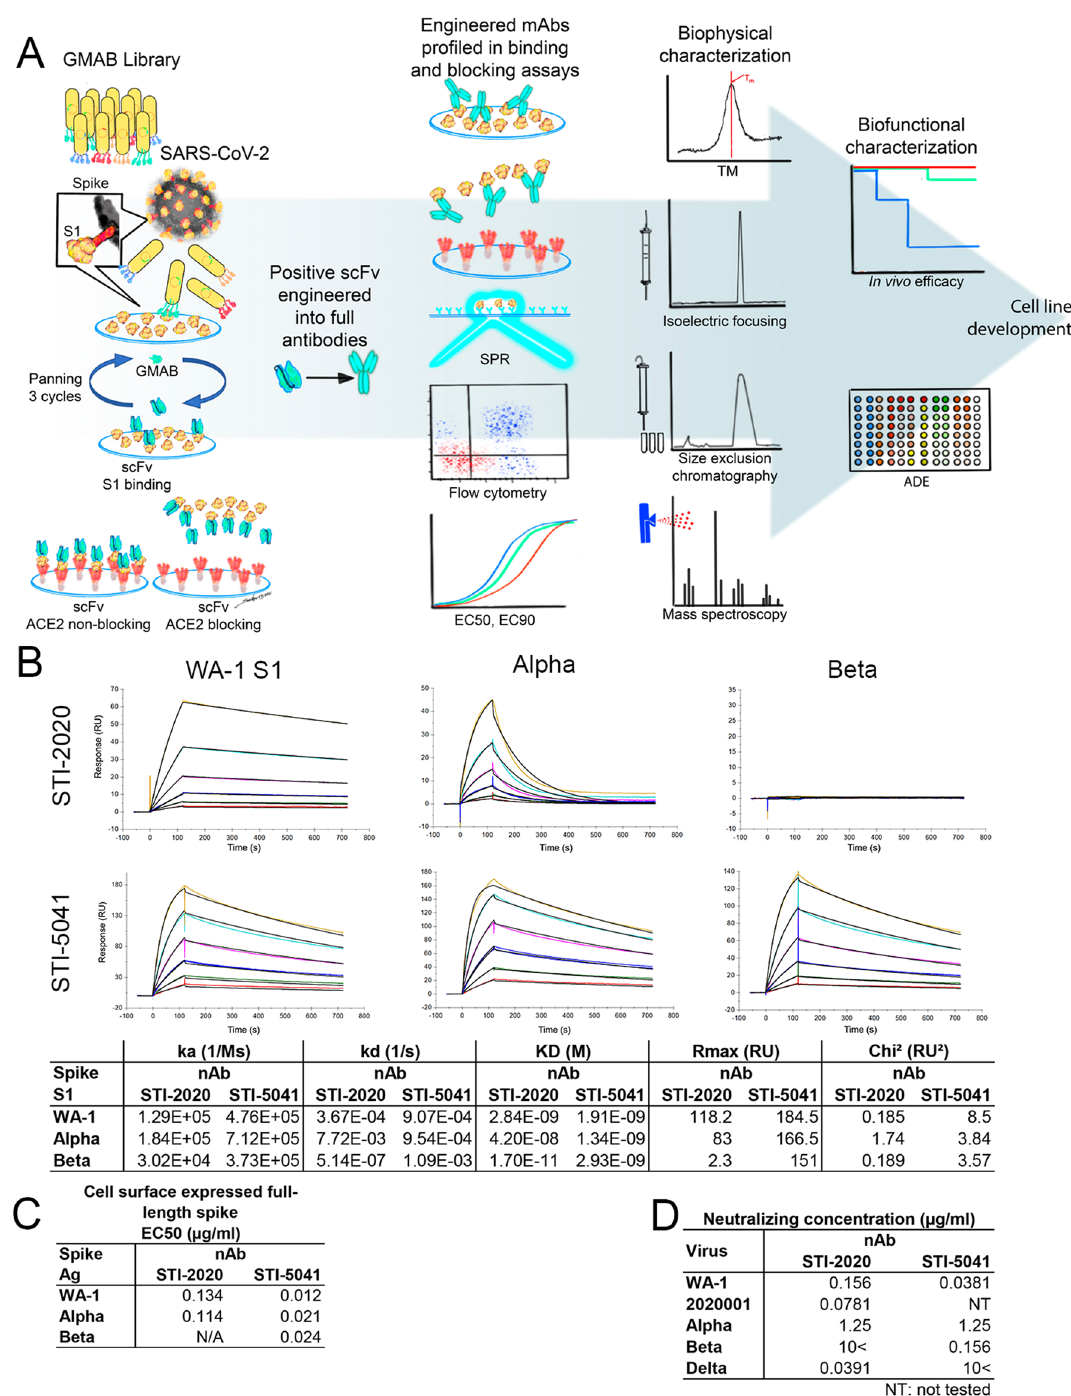
Figure 1. Rapid Discovery of Neutralizing Antibodies. ( A ) The G-MAB phage display library was panned for SARS-CoV-2 Spike S1 subunit-binding scFv fragments. Following confirmation of binding activity and blocking of S1:ACE2 interactions by candidate scFvs, the most potent of these candidates were converted to IgG1 antibodies bearing the LALA Fc modification. Candidate nAbs were characterized for binding of Spike S1 subunit and neutralization of related clinical SARS-CoV-2 isolates. Affinity maturation of potent nAbs was carried out in parallel to biophysical profiling, cell line development, and evaluation of protective efficacy for the parental nAbs, S1D2 and S7E3 to yield STI-2020 and STI-5041, respectively. Artwork credit: William SooHoo. ( B ) Affinity measurements of STI-2020 and STI-5041 for Spike S1 domain from the following isolates and VOCs: USA/WA-1/2020(WA-1) isolate, D614G 2020001 isolate, B.1.1.7 VOC (Alpha), B.1.351 VOC (Beta). The antibody affinities were measured using SPR on a BIAcore T200 instrument using a 1:1 binding model. ( C ) Spike protein derived from the WA-1 and 2020001 (D614G) SARS-CoV-2 isolates were independently expressed on the surface of HEK 293 cells. Serially-diluted STI-2020 or STI-5041 were assayed for Spike protein binding by flow cytometry. To quantify antibody binding, mean fluorescent intensity was measured for each dilution tested and the EC 50 value was calculated for each nAb. Representative replicate experiments are shown. ( D ) STI-2020 and STI-5041 were evaluated in neutralizing test for potency against SARS-CoV-2 USA/WA-1/2020, 2020001 (D614G), B.1.1.7 VOC (Alpha), B.1.351 VOC (Beta) and B.1.617.2